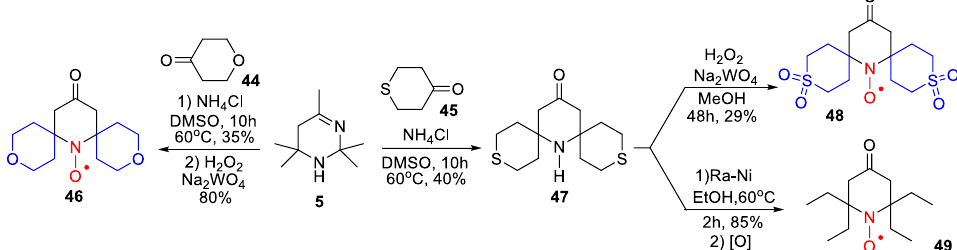
Scheme 8. Interaction of acetonine 5 with heterocyclic ketones.